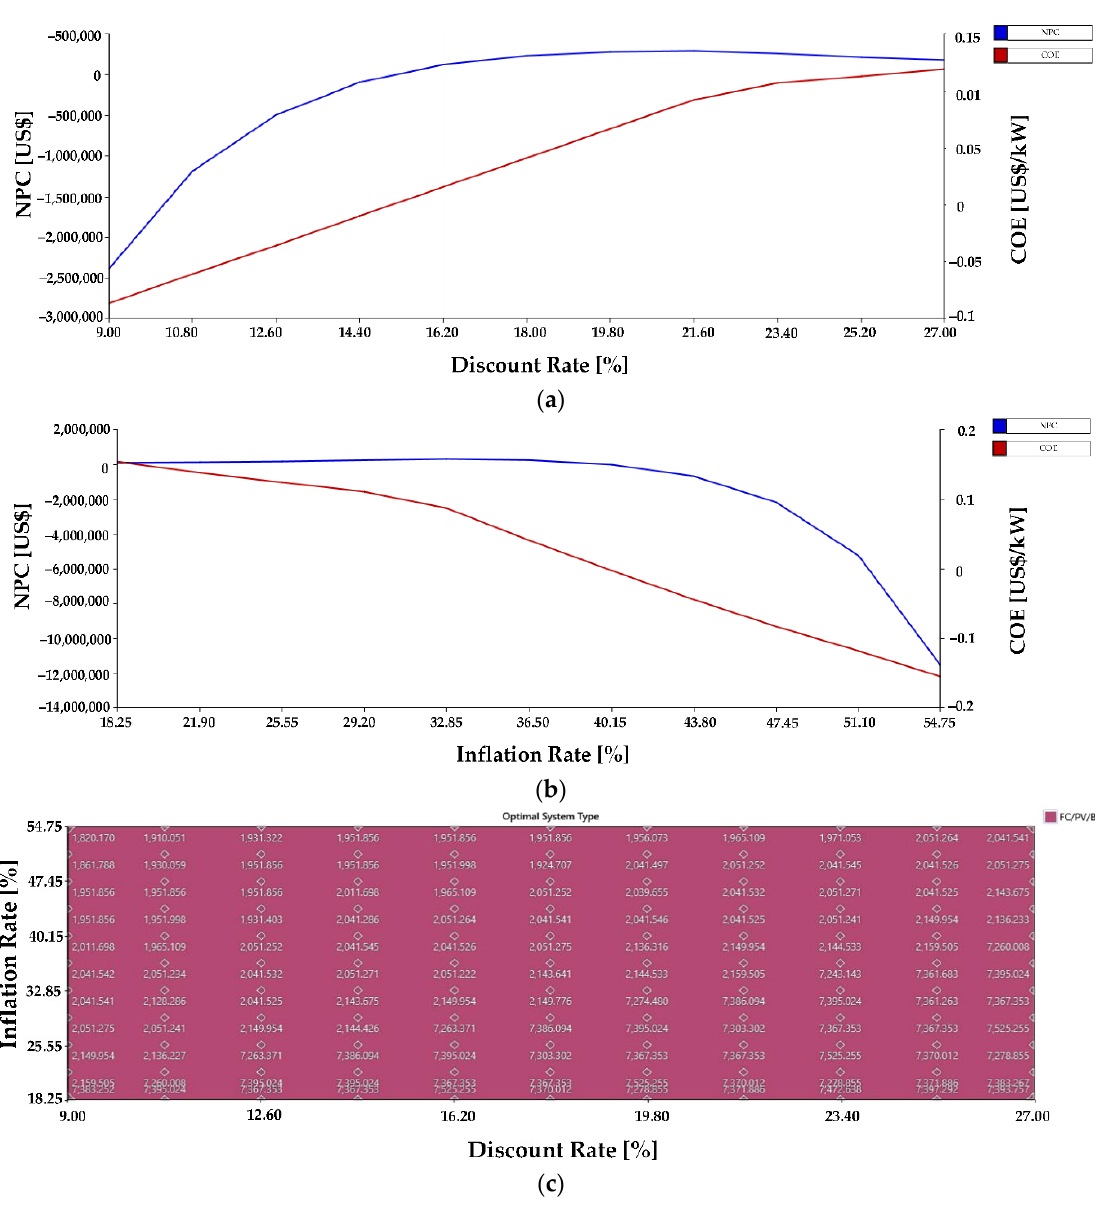
Figure 20. Sensitivity analysis on: ( a ) discount rate; ( b ) inflation rate; ( c ) optimal